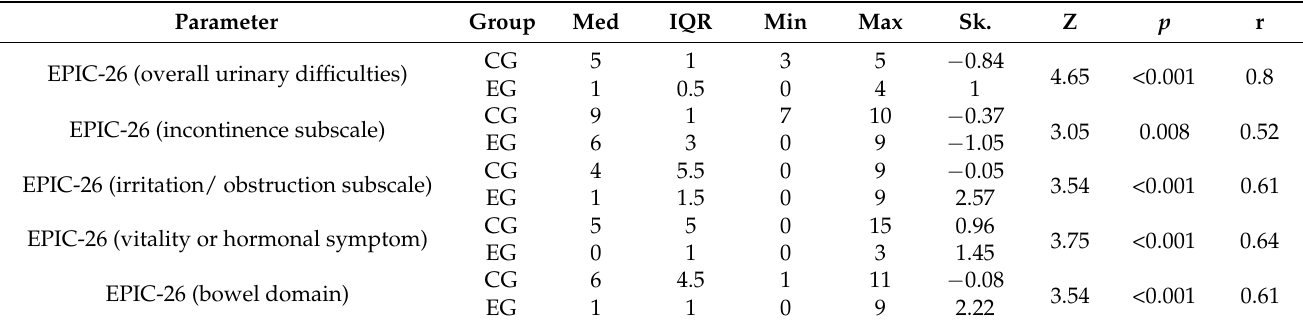
Table 5. Comparative analysis of all measured variables for the EG and the CG at the final assessment. Parameter Group Med IQR Min Max